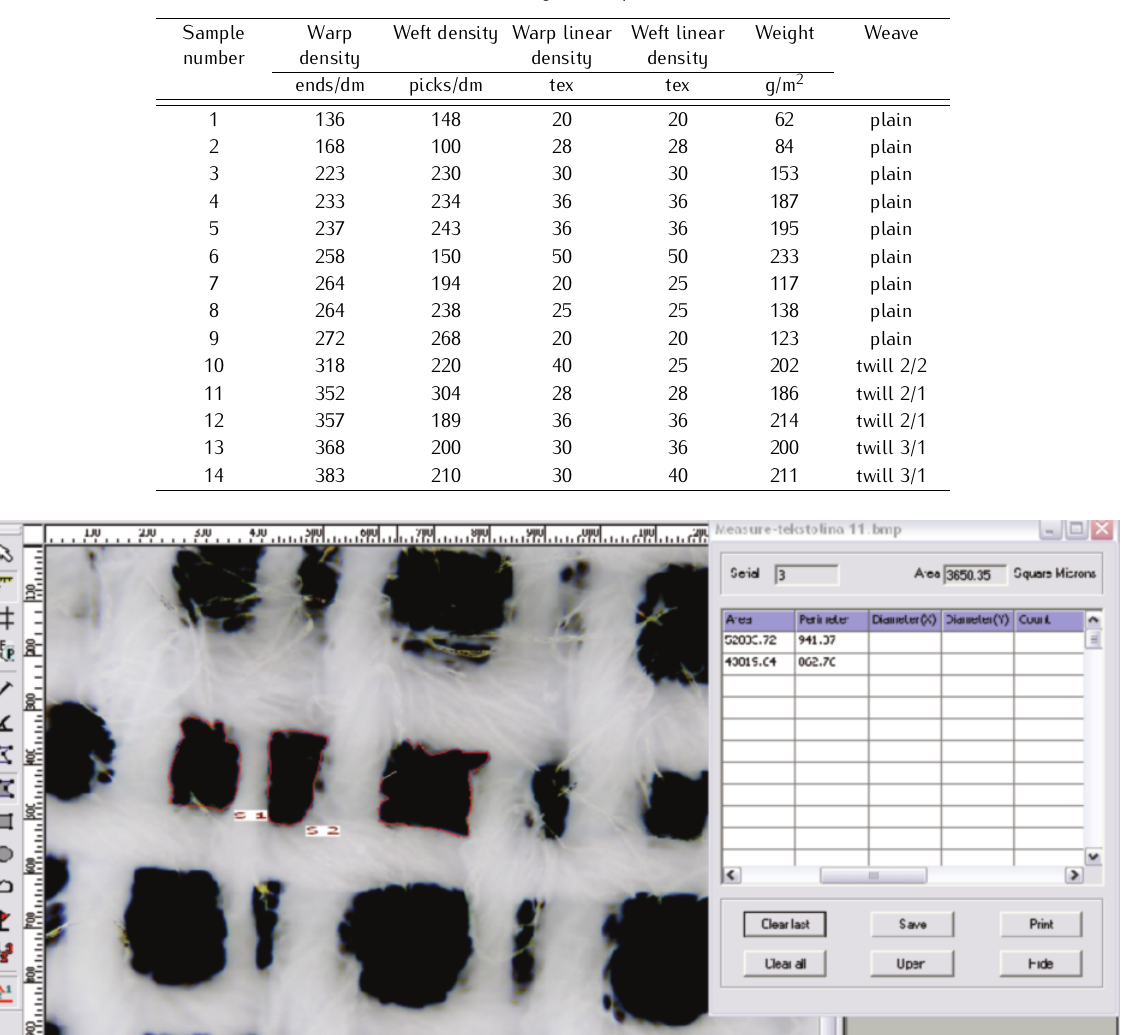
The statistical analysis and the examples on Fig. 5 un- doubtedly show that single values of the pore area are highly uneven and spread far beyond the limits of the standard deviation. The reason for this result can be found in the unevenness of the yarn diameter, the influence of the beat-up mechanism of the weaving machine on the pore size and the instability of the woven structure. How- ever, it can be seen that the results for the pore area for the plain weave are much more irregular and spread around the mean value, compared to the results for the twill weave. Possible explanation can be found in